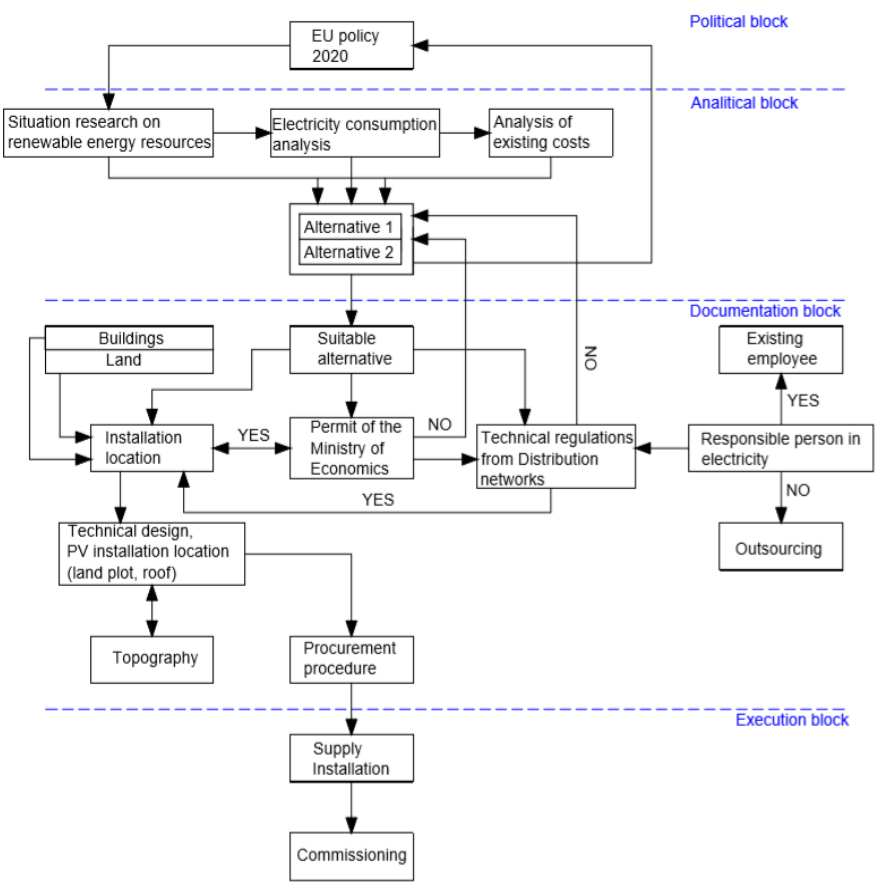
Fig. 5. Analytical algorithm for solar PV panel